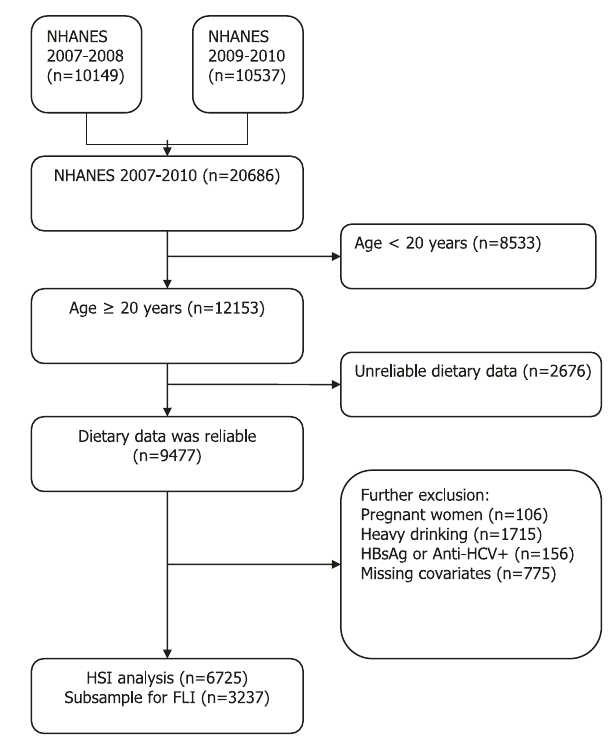
Fig. 1 Flowchart of the study participants selection. A total of 6725 and 3237 participants were selected from the two cycles of National Health and Nutrition Examination Survey (NHANES) for hepatic steatosis index (HSI) and fatty liver index (FLI)